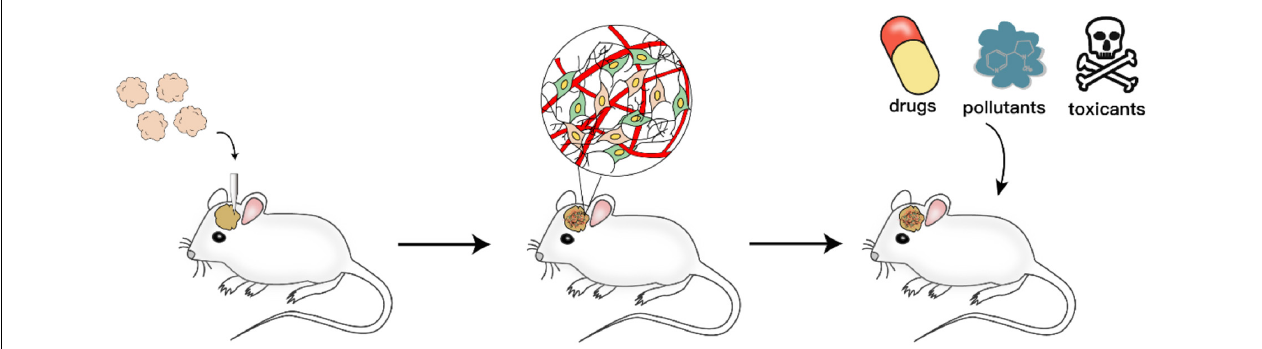
FIGURE 2 | Human-mouse chimeric brain in neurotoxicity study. Brain organoids are transplanted into the mouse brain to establish a human-mouse chimeric brain model. Two to three months after human cells are incorporated into the host brain, the test compounds are administered to the mice. Then, subsequent readouts of neurotoxicity could be obtained by behavioural tests, immunohistochemistry, electrophysiology and other experiments.